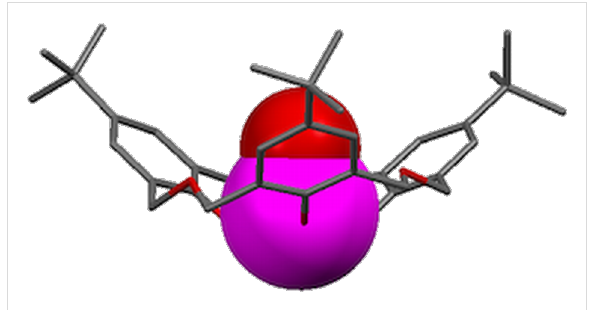
Figure 15: X-ray crystal structure of the 3b -vanadyl complex (CCDC ID 240185) [57].